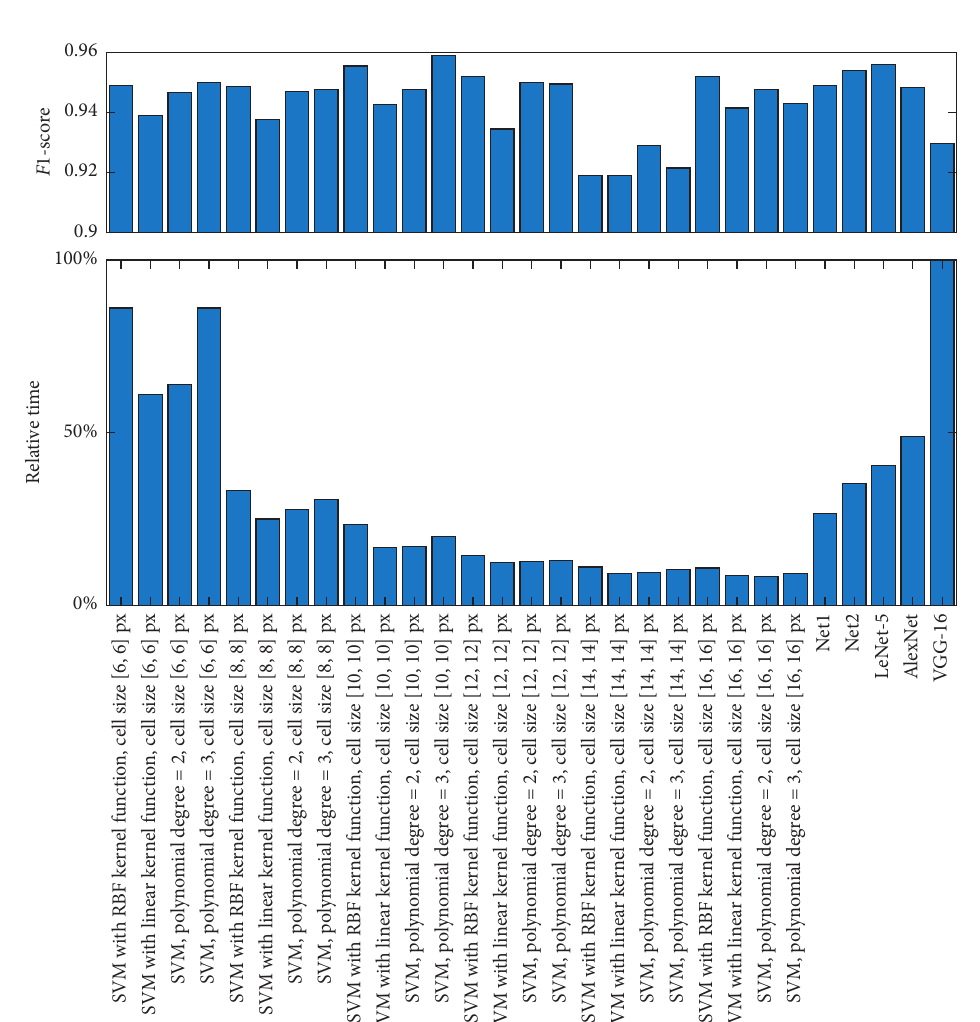
Figure 12: Relative computational times of the passenger recognition systems in comparison with F 1-score of each